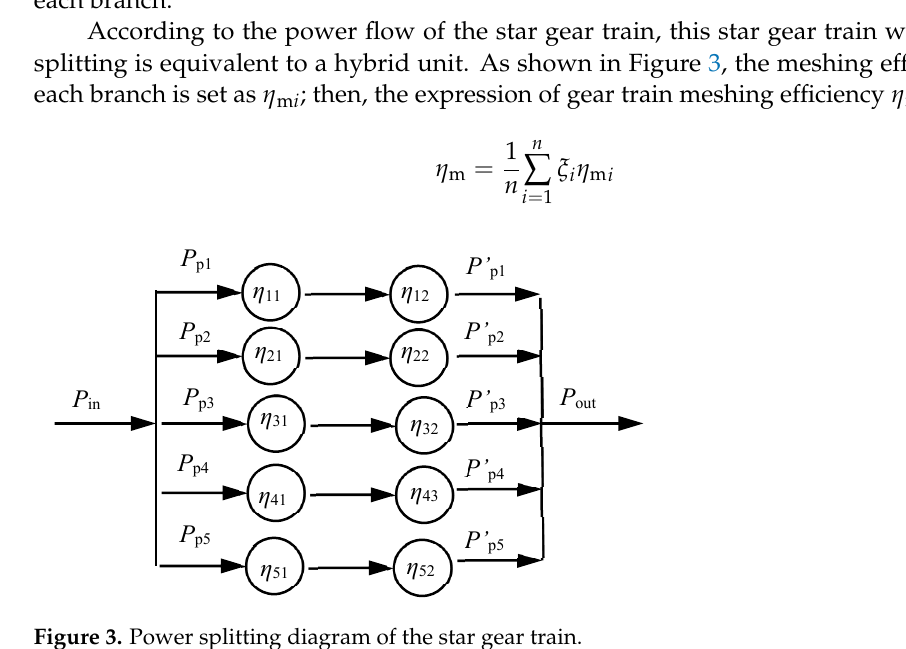
4 of 13 Figure 2. The mechanism motion diagram of herringbone tooth star gear train.